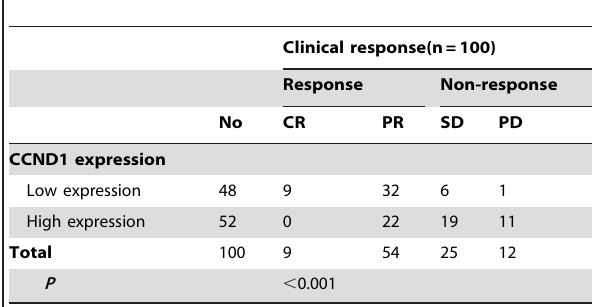
Figure 2. Kaplan-Meier survival curves for different treatment protocols and biomarker as well as the impact of treatment procedure according to CCND1